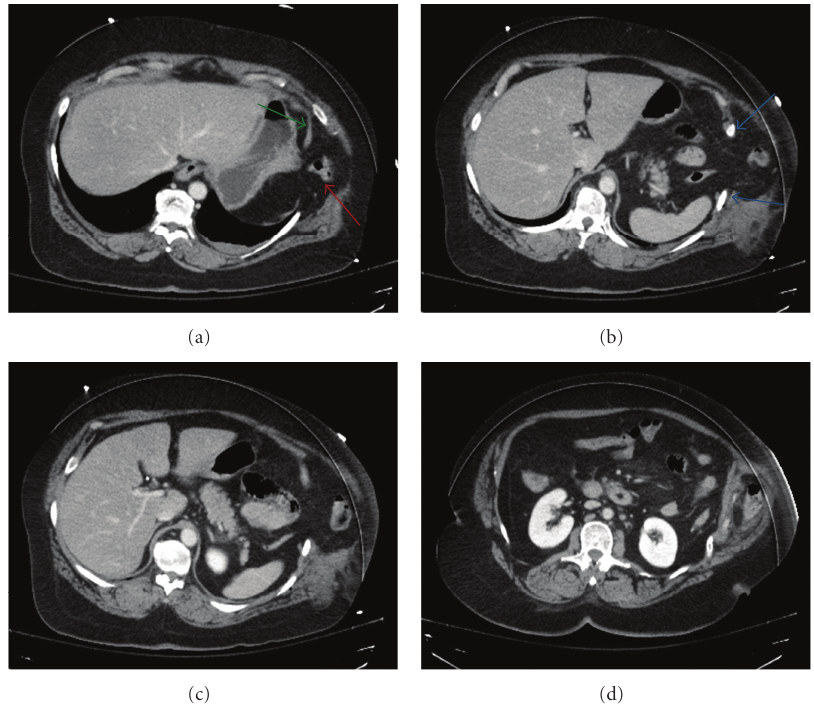
Figure 2: Axial CT images of the abdomen demonstrate herniation of abdominal contents is present including omentum and transverse colon into the chest and through the intercostal defect forming a hernia sac composed of peritoneum (red arrow) (a). There is discontinuity of the diaphragm (green arrows) and widened intercostal space (blue arrows).